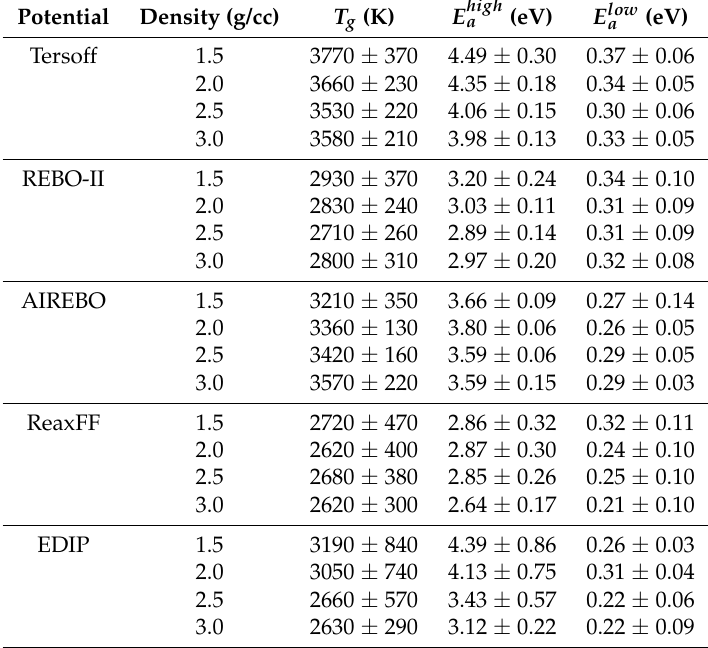
Table 1. Glass-transition temperature ( T g ), and activation energies of disordered carbons for the five potentials and four densities. Uncertainties are 95% confidence limits determined from the regression